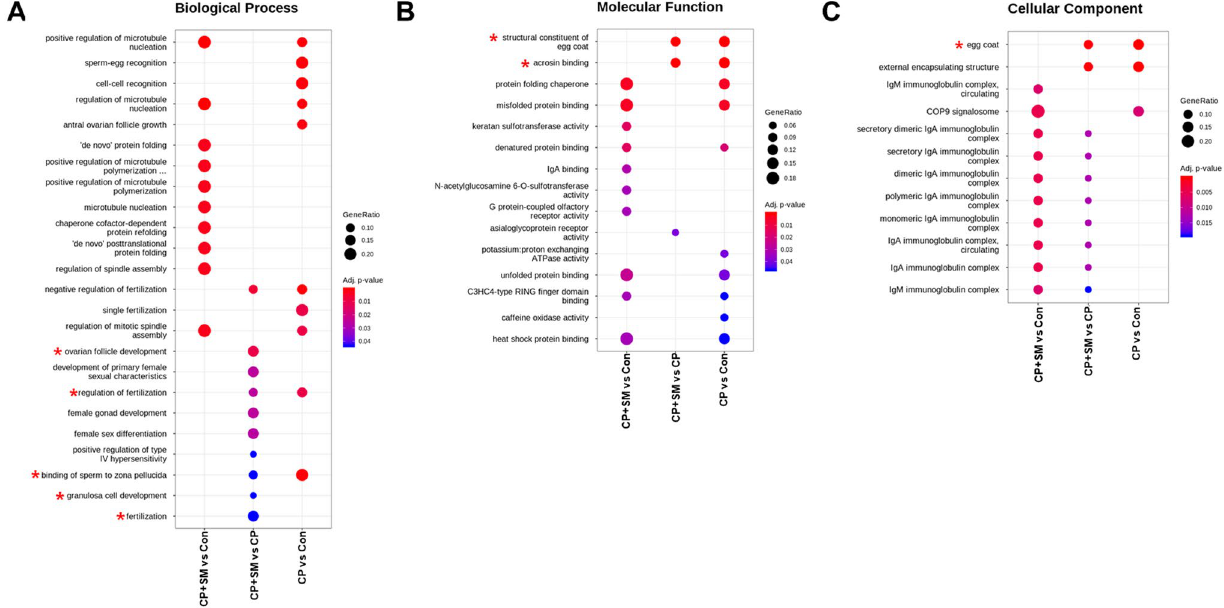
Figure 7. Gene Ontology (GO) and KEGG analysis of differentially expressed mRNAs. Targets were subjected to pathway analysis using KEGG and subsequently classified based on their enrichment in ( A ) biological process, ( B ) molecular function, and ( C ) cellular component GO terms. Asterisks (*) indicate the most important biological processes altered by SM administration compared to those in CP mice. Con saline-treated control mice; CP cyclophosphamide-treated mice; CP + SM CP-treated mice orally administered